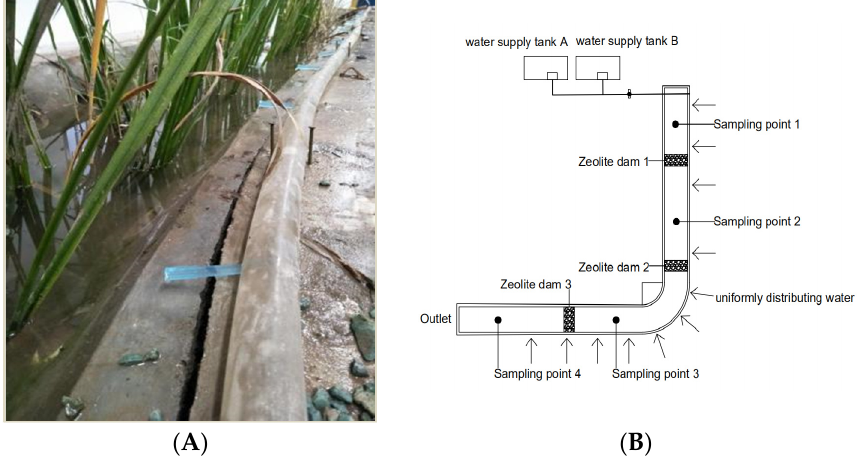
Figure 4. Holes of water distribution ( A ); distribution of sampling points ( B ).